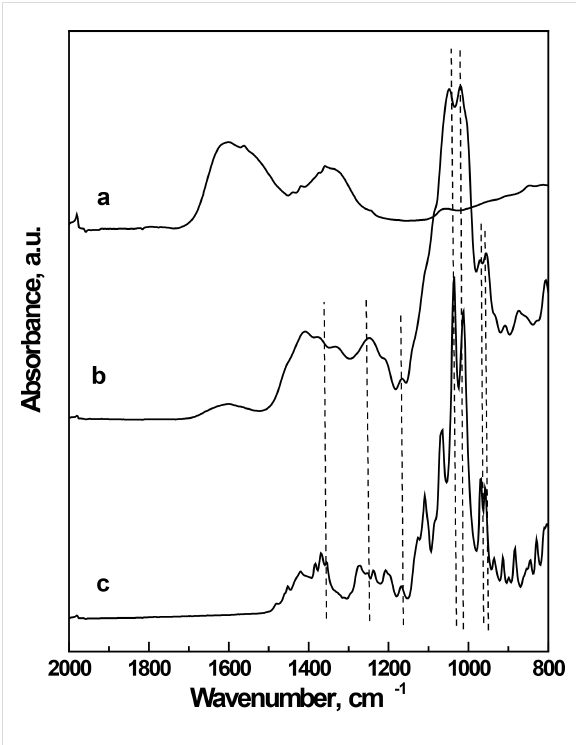
Figure 2: ATR-FTIR spectra of γ -Fe 2 O 3 particles before (a) and after (b) coating with D- mannose. Spectrum (c) belongs to pure D-mannose.